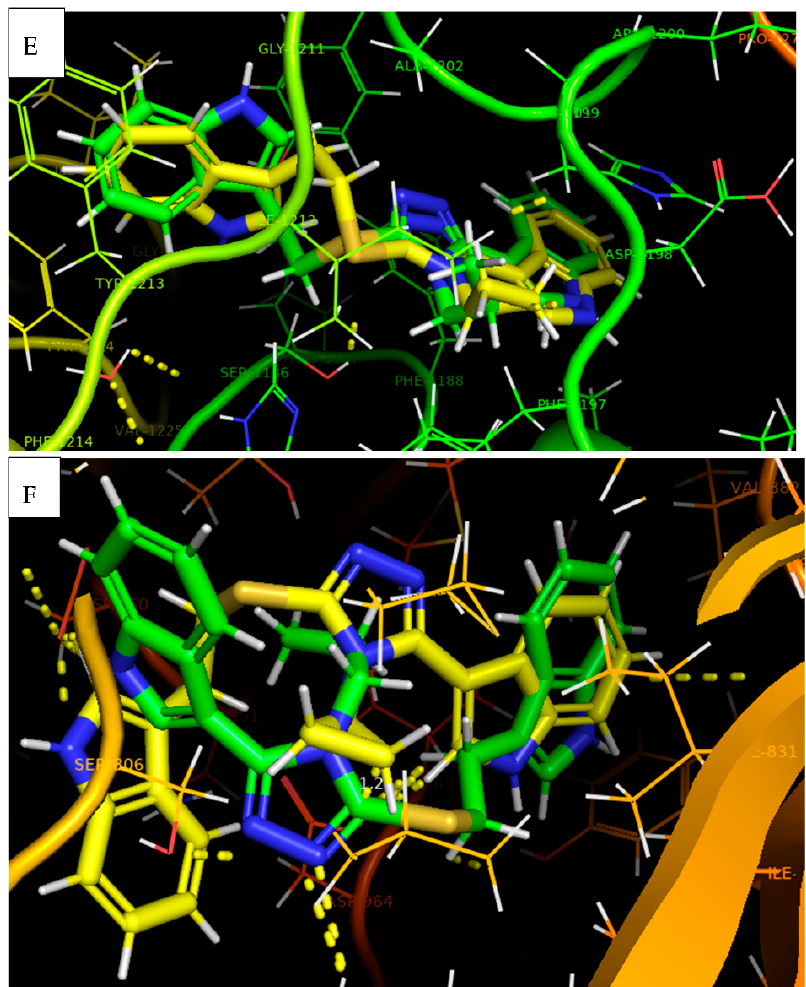
Figure 10. ( A ) Docking pose of 15r in PDB ID 4OA7 shown in a 2D structure, where indole NH bonded with TYR 1203 via H-bonding, which is represented by the pink arrow line; similarly, triazole N bonded with ASP 1198. On the other hand, the indole shows a Pi–Pi stacking with HID 1201, represented by the green line. ( B ) Docking pose of 15o in PDB ID 4OA7 shown in a 2D structure, where both indoles show Pi–Pi stacking with HID 1201, TYR 1203, and TYR 1224, represented by the green line. ( C ) Docking pose of 15r in PDB ID 3L54 shown in a 2D structure, where indole shows Pi–Pi stacking with TYR 867, represented by the green line. ( D ) Docking pose of 15o in PDB ID 3L54 shown in a 2D structure, where indole NH and triazole N bonded with LYS 833 and ASP 950, respectively, via H-bonding, represented by the pink arrow line. On the other hand, the indole shows Pi–Pi stacking with TYR 867, represented by the green line. ( E ) Superimposable poses of 15r and 15o in PDB ID 4OA7 shown in a 3D structure. ( F ) Superimposable poses of 15r and 15o and standard in PDB ID 3L54 shown in a 3D structure. 15r and 15o are represented by green and yellow colours. In PDB ID 3L54, phosphoinositide 3-kinase (PI3K) protein and conjugate 15r showed